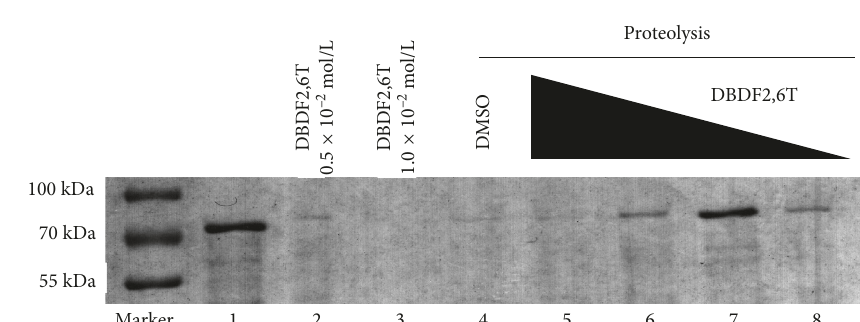
Figure 6: DARTS detection via SDS-PAGE. Band 1 was pure hPPAR c protein without incubation with DBDF2,6Tor proteolysis; bands 2 and 3 were hPPAR c protein incubated with 0.5 to 8 were hPPAR c protein incubated with DMSO and different concentrations of DBDF2,6T (5 4 mol/L, and 0.5 0.5 10 × −